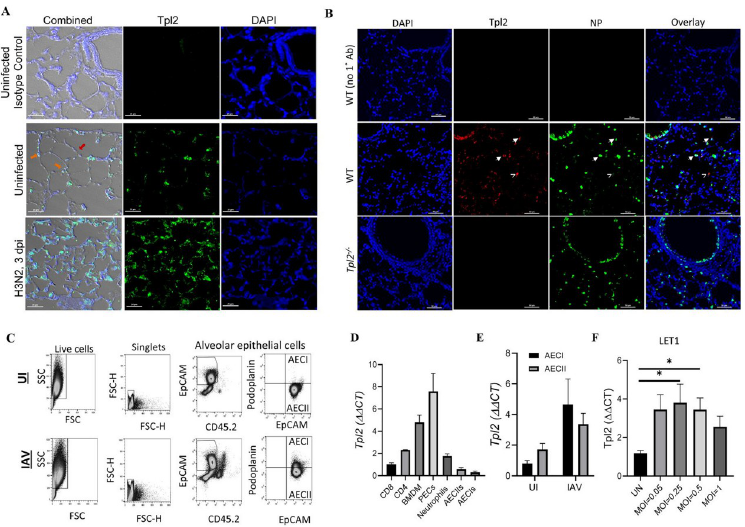
Fig 1. Tpl2 is expressed in pulmonary epithelial cells, and expression increases upon influenza infection. (A) Representative images of Tpl2 expression within 4- μ m lung sections mounted onto glass slides from wild-type (WT) mice. WT mice were either uninfected or infected with 10 4 PFU influenza A/ HK-x31 (x31) for 3 days. Lung sections were stained with rabbit anti-mouse IgG Isotype control or anti-mouse Tpl2 (Santa Cruz Biotechnology, clone M20) followed by goat anti-rabbit IgG AlexaFluor 488, and the nuclei were counterstained with DAPI. Slides were imaged using confocal microscopy. Data are representative of 3 experiments. Orange arrows—AECIIs, Red arrow—AECIs. (B) Representative images of influenza A/x31 nucleoprotein (NP) and Tpl2 expression in lung sections from WT and Tpl2 -/- mice infected with influenza for 3 days as in A. Cells were stained with anti-NP antibody (with AlexaFluor 488 secondary) and anti-Tpl2 M-20 (with AlexaFluor 594 secondary) with a DAPI counterstain. Carets denote Tpl2 co- staining with NP dim cells; arrowheads denote Tpl2 co-staining with NP bright alveolar cells. Data are representative of at least 3 mice. (C) Representative flow plot from lung cells magnetically depleted with biotinylated antibodies against hematopoietic cells (CD45), alveolar macrophages (CD45 and CD16/32), endothelial cells (CD31), erythroid cells (Ter119), club cells (integrin β 4), and distal lung progenitor cells (integrin β 4) prior to staining for distinction between AECI and AECII. AECI (EpCAM + CD45.2 - Podoplanin + ) and AECII (EpCAM+CD45.2-) populations were gated as shown and sorted for RT-PCR analyisis of Tpl2. (D) Na ï ve splenic CD4 + and CD8 + T cells, bone marrow-derived macrophages (BMDM), adherence purified peritoneal exudate cells (PECs), neutrophils, and lung alveolar epithelial cells (AECI and AECII) were isolated from WT, age- and sex-matched mice as in C. Tpl2 expression was measured by RT-PCR relative to an actin control. All samples were normalized to CD8 + T cells, which were arbitrarily designated 1. Data are representative of 3 experiments. (E) Isolated alveolar epithelial cells (AECI and AECII) from WT, age- and sex-matched mice as in C were uninfected or infected with 10 4 PFU influenza A/x31 for 3 days. Tpl2 expression was quantified by RT-PCR. N = 4. (F) LET1 cells were cultured for 24 hours then left uninfected or infected with a MOI of 0.05, 0.25, 0.5, or 1 of influenza A/x31 (H3N2) for 24 hours. RNA lysates were collected after 24 hours, and Tpl2 expression was measured by RT-PCR. Pooled data from 3 experiments. Error bars represent means ± SEM. Error bars represent means ± SEM. � p < 0.05, �� p < 0.01, ��� p < 0.001, ���� p < 0.0001; one-way ANOVA.